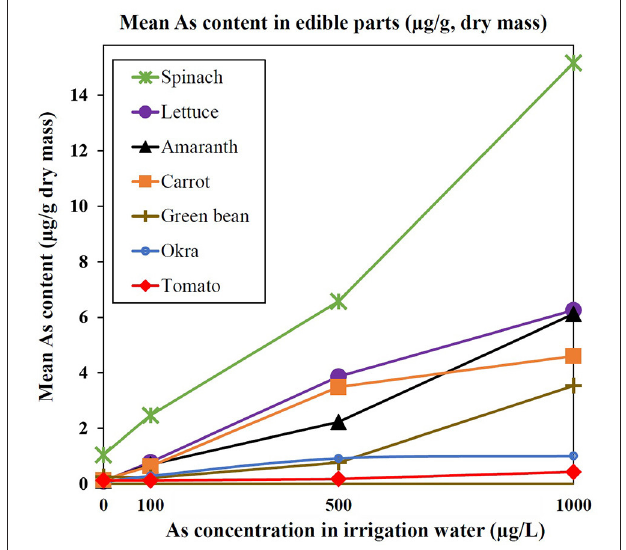
FIGURE 2 | Mean As content ( µ g/g, DM) in edible parts of cultivated plants as a function of As in the irrigation water ( µ g/L). Error bars are given in Supplementary Table 4 .